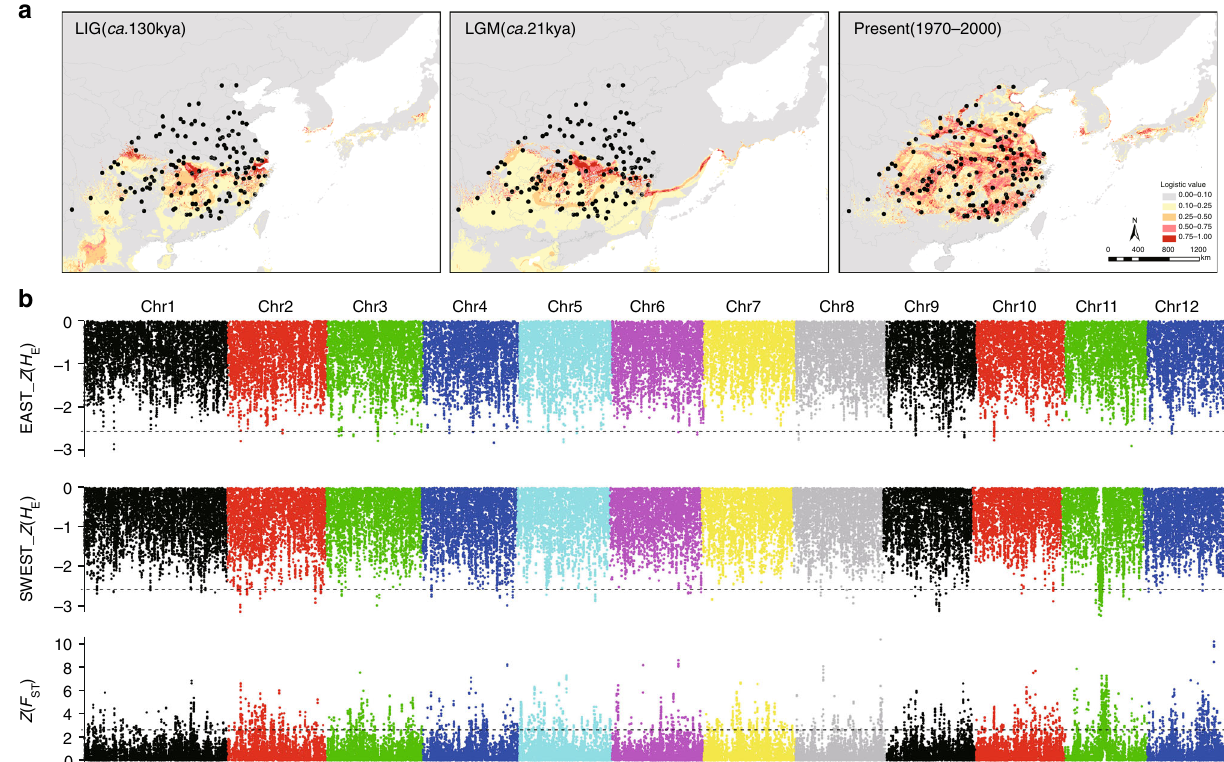
Fig. 4 Putative selected regions identi fi ed in the EAST and SWEST groups. a Predicted distributions of ginkgo trees at different historical periods based on species distribution modeling (SDM). Area color indicates probability (0 – 1) of suitable habitat for ginkgo. LIG, last interglacial; GM, last glacial maximum. The map image was derived from ArcGIS. b Distribution of the Z -score-transformed expected heterozygosity ( H E ) and F ST for EAST-g and SWEST-g in 100 kb nonoverlapping sliding windows along chromosomes. Horizontal dotted lines represent the cutoff ful fi lling the requirement for the selected regions. The source data of Fig. 4b are provided in a Source Data fi